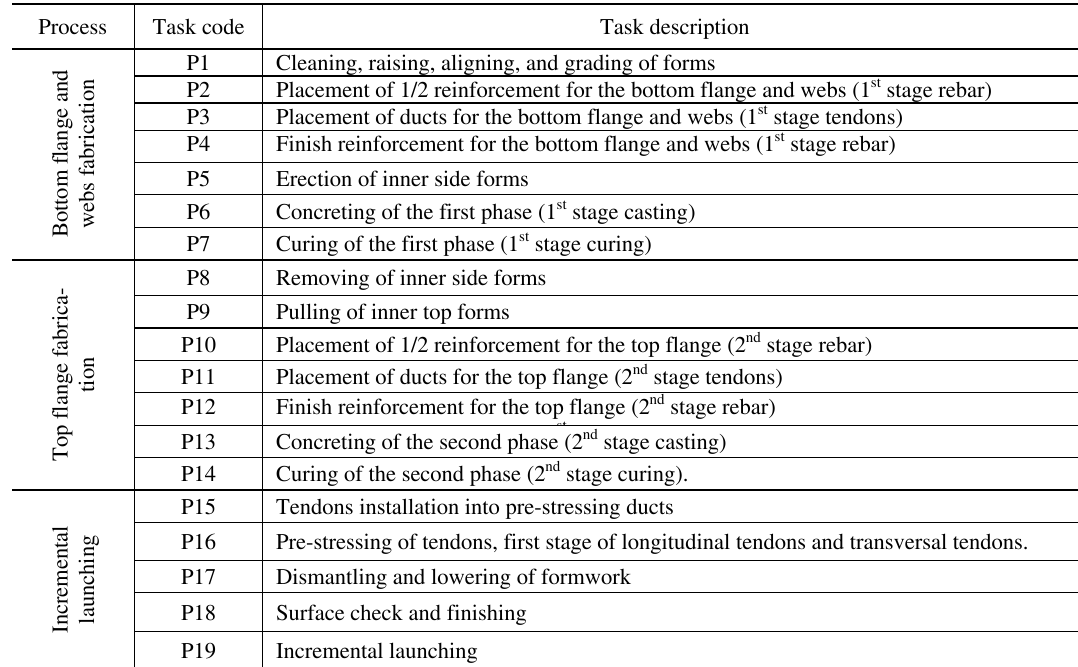
Table 2 . Processes and tasks of single form method